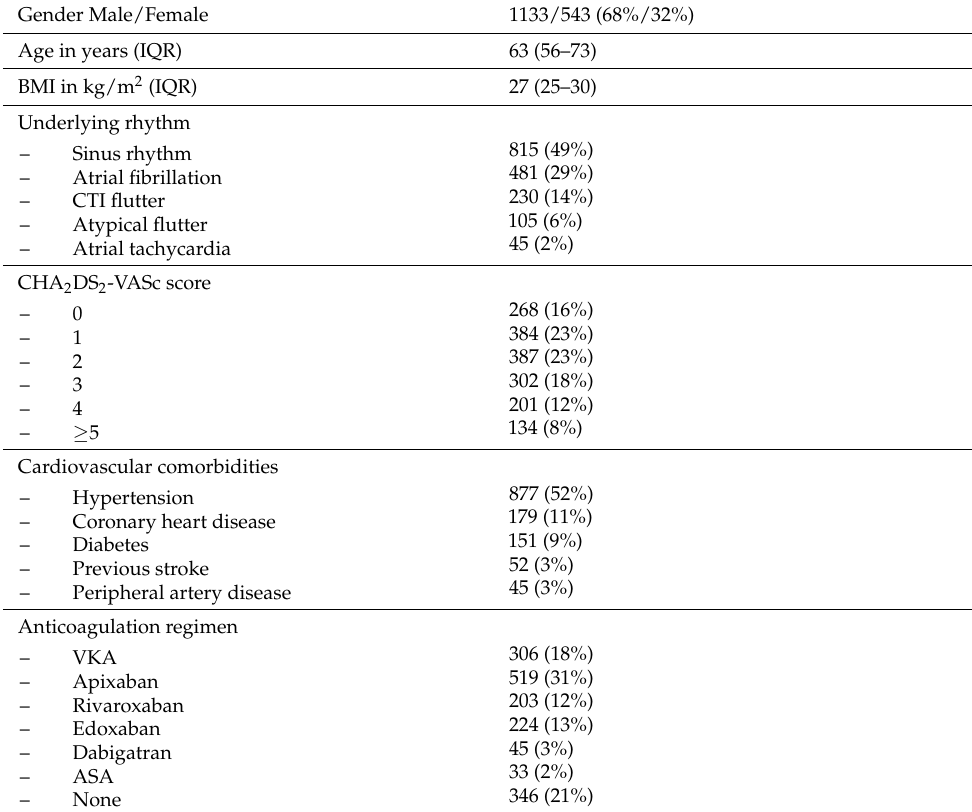
Table 1. Baseline characteristics of all